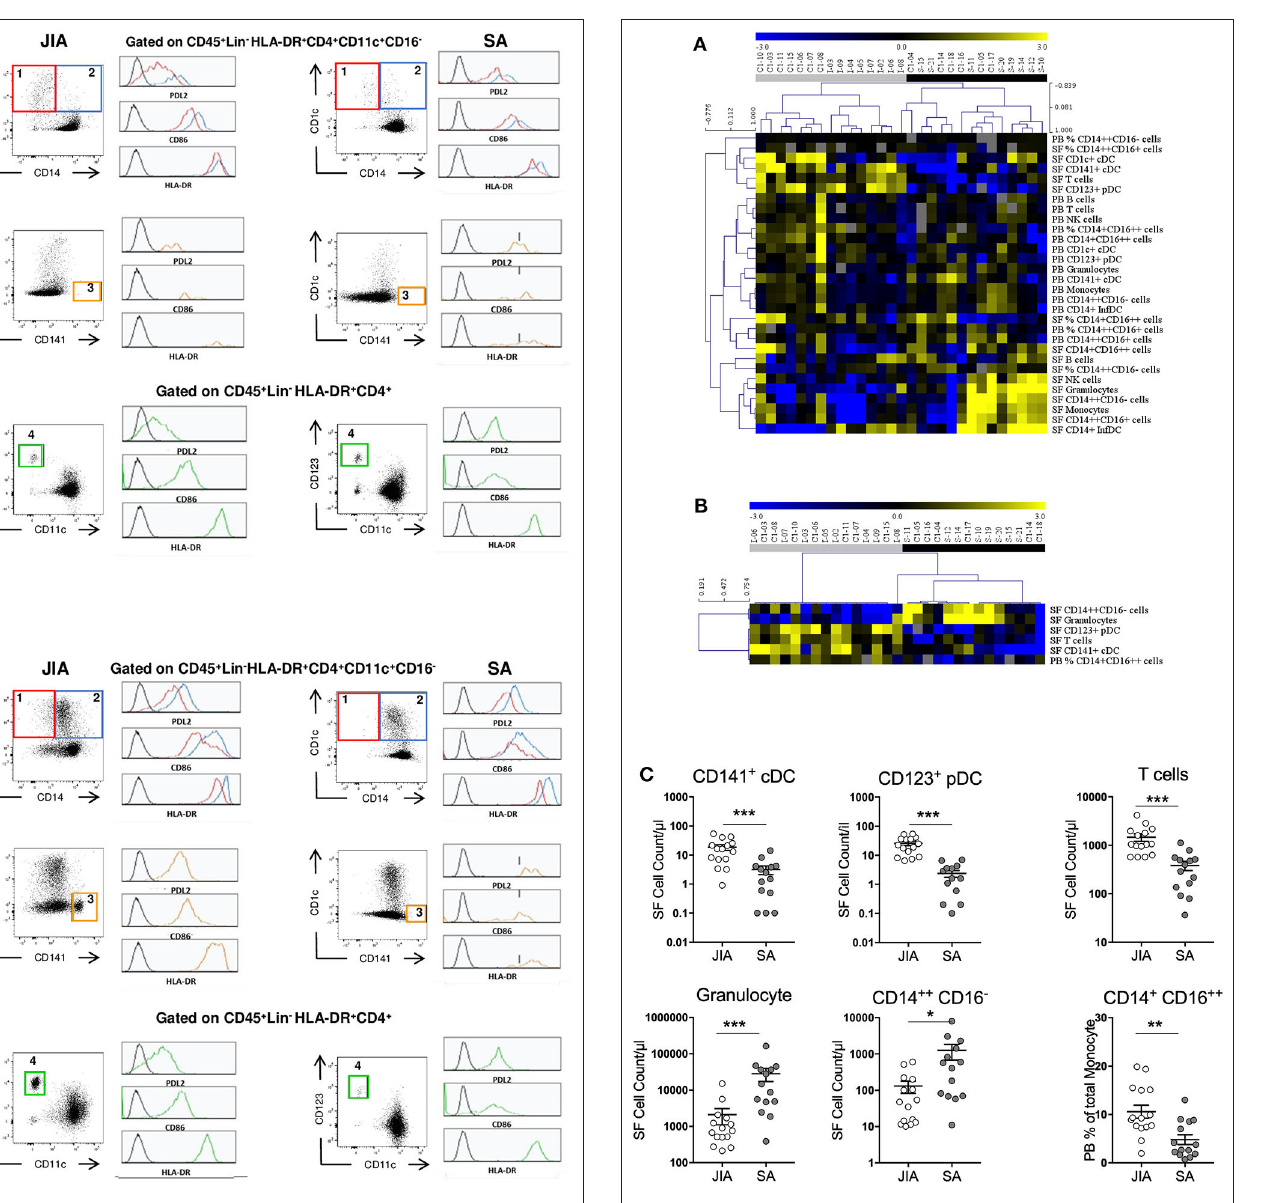
FIGURE 2 | Representative staining of DC subsets. Representative dot plot of the CD1c + cDC (1, red), CD14 + InfDCs (2, blue), CD141 + cDC (3, orange) and CD123 + pDC(4, green) and representative histograms for the various markers (PDL2, CD86, HLA-DR) on each subset (A) in peripheral blood and (B) in synovial fluid of patients with JIA (left) or SA (right). Black histograms correspond to negative control MFI. cDC and HLA-DR and PDL-2 expression on SF CD123 + pDC ( Table 3 ).